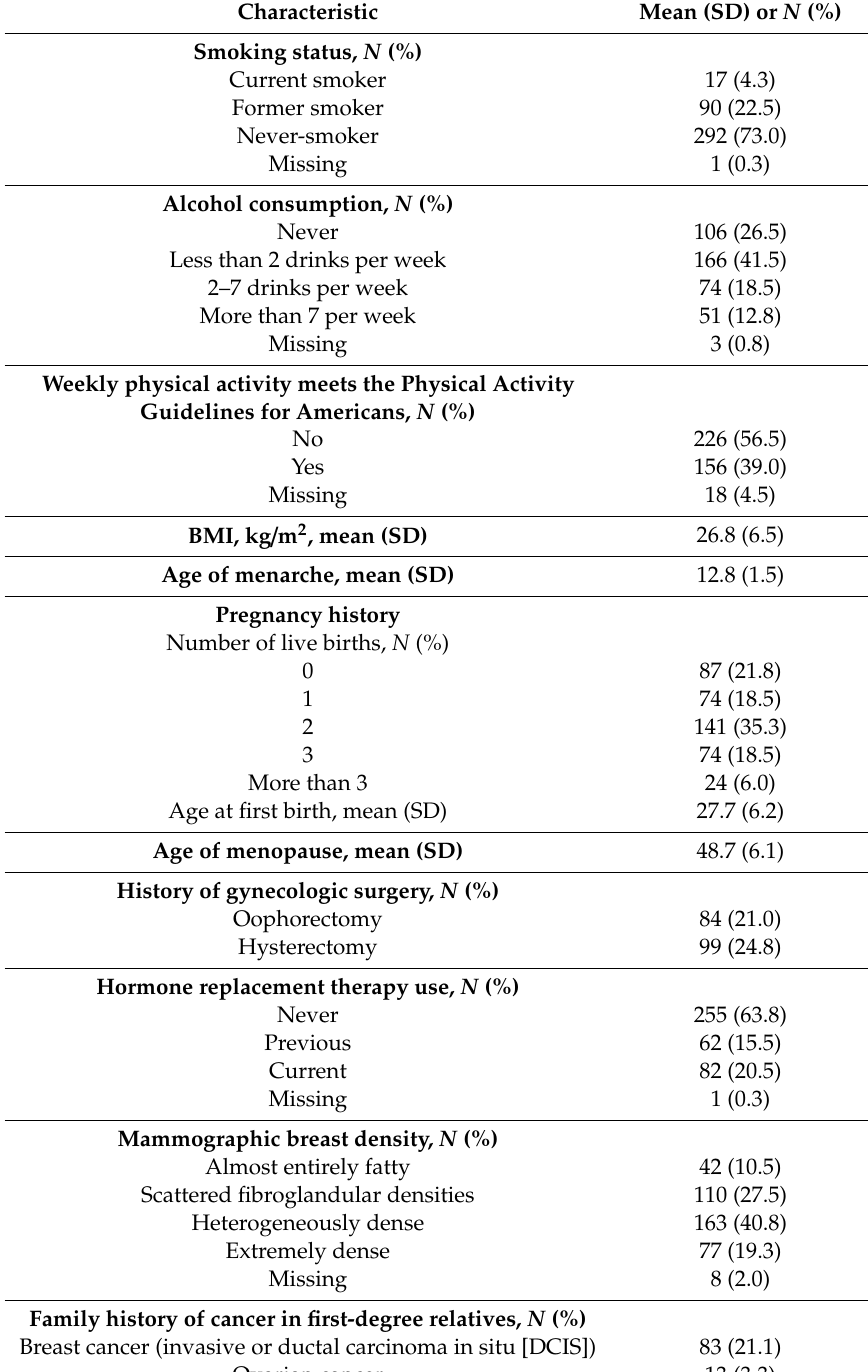
Table 3. Lifestyle factors and health histories among study